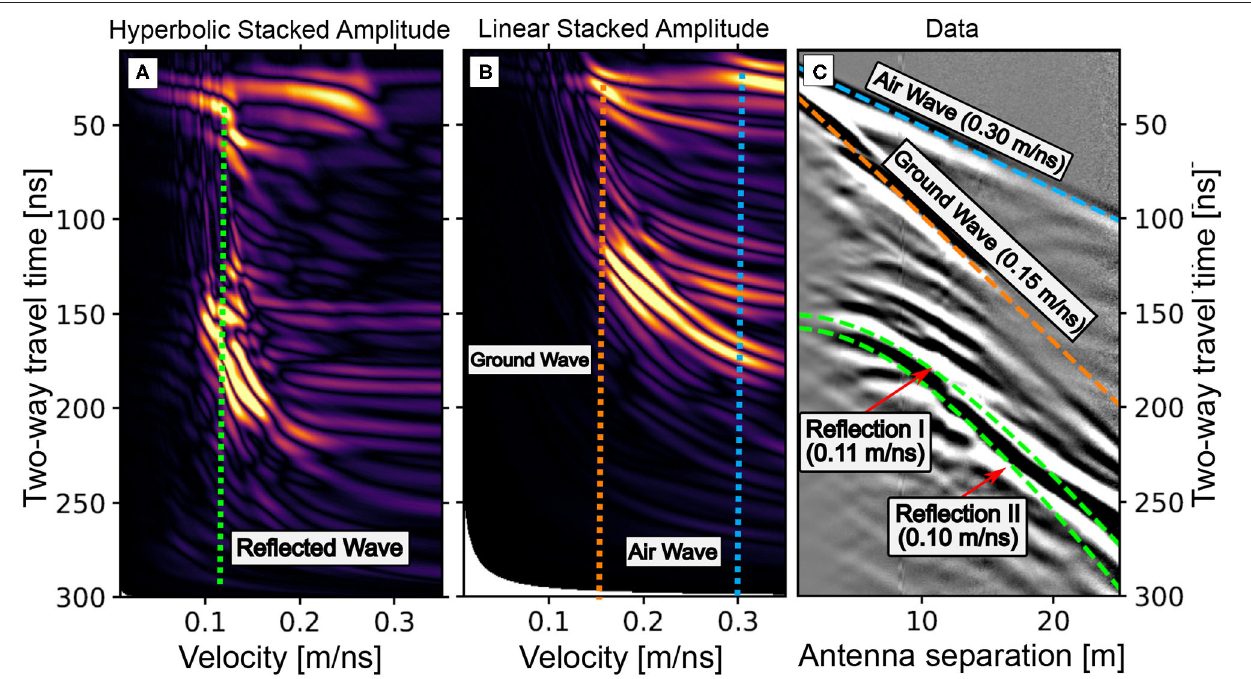
FIGURE 3 | (A) hyperbolic stacked amplitudes for the WARR data in (C) . Bright colors indicate velocities and depths (two-way travel time) of interfaces. (B) linear stacked amplitudes for the WARR data in (C) . Bright colors indicate velocities for direct waves. (C) WARR data with best-fitting lines and hyperbolae obtained from (A,B)